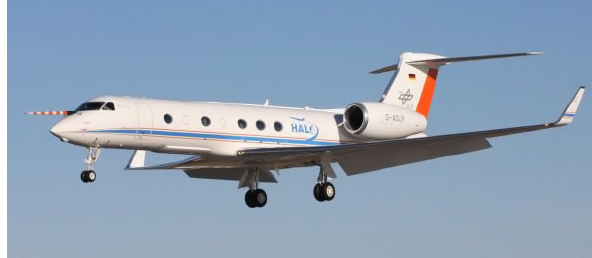
Figure 1. HALO (High Altitude and LOng range) aircraft. Photo adopted from